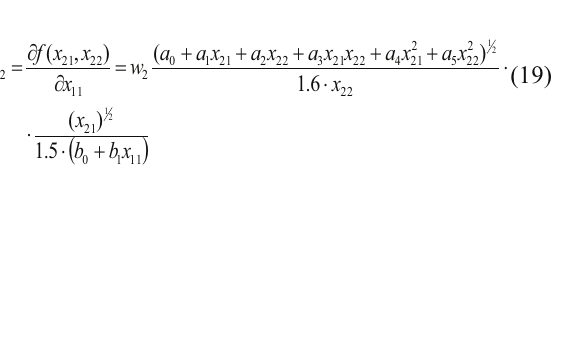
Fig. 3. Backward connections of the 3rd layer 1st block (dashed lines) in the 3-variable multi-layer